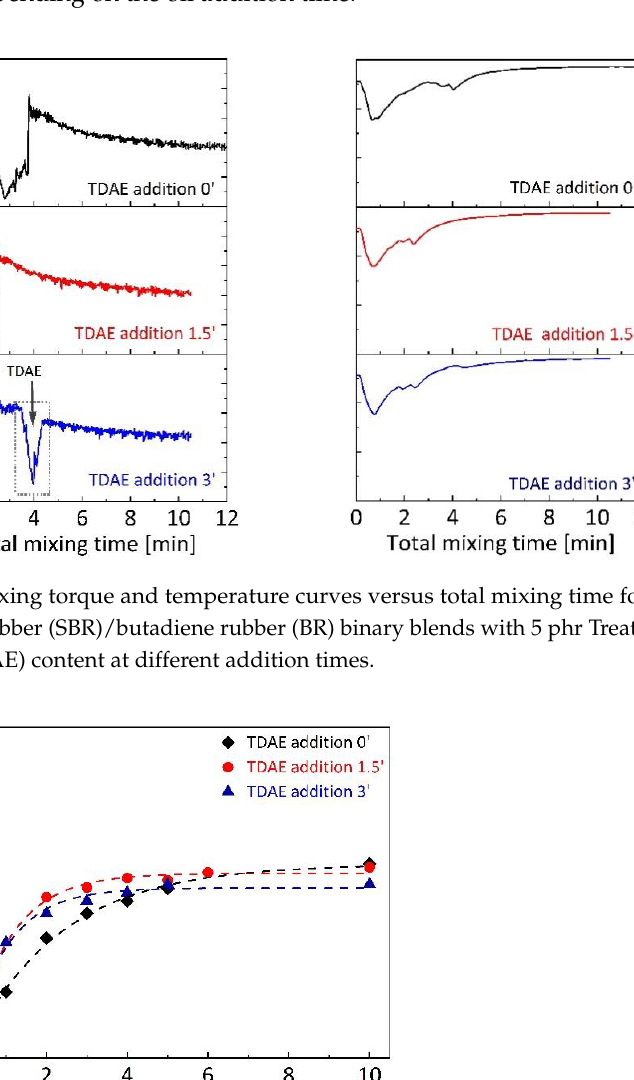
Figure 2. Dependence of rubber layer L development during mixing on TDAE addition time for silica-filled SBR/BR binary blends.